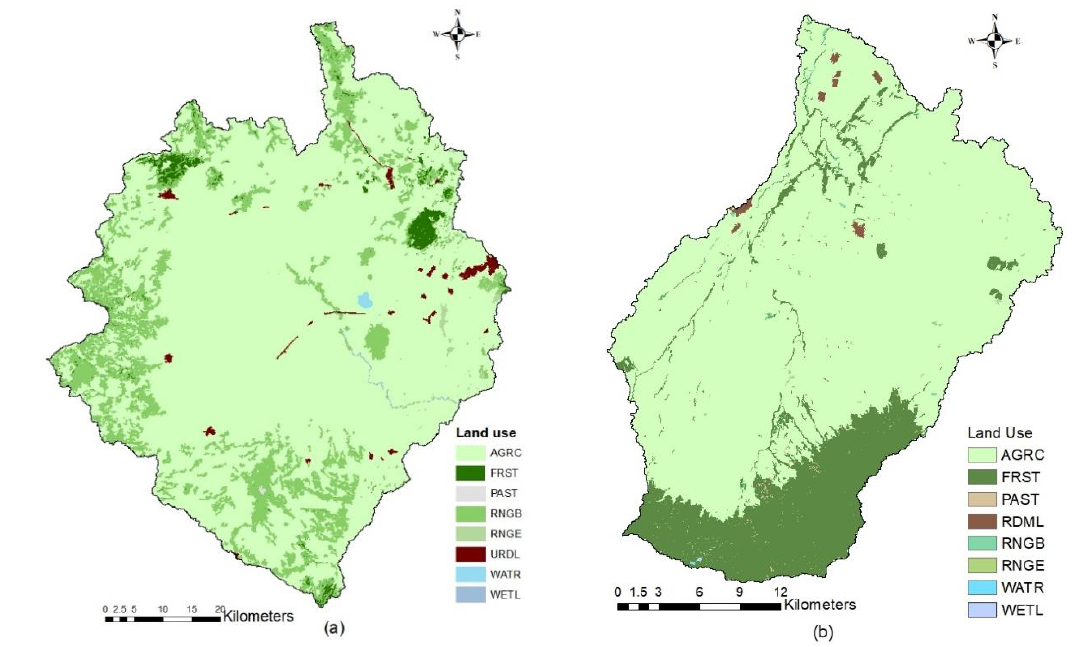
Figure 2. Land use map used at the ( a ) Melka Kunture and ( b ) Keleta sub-basins.